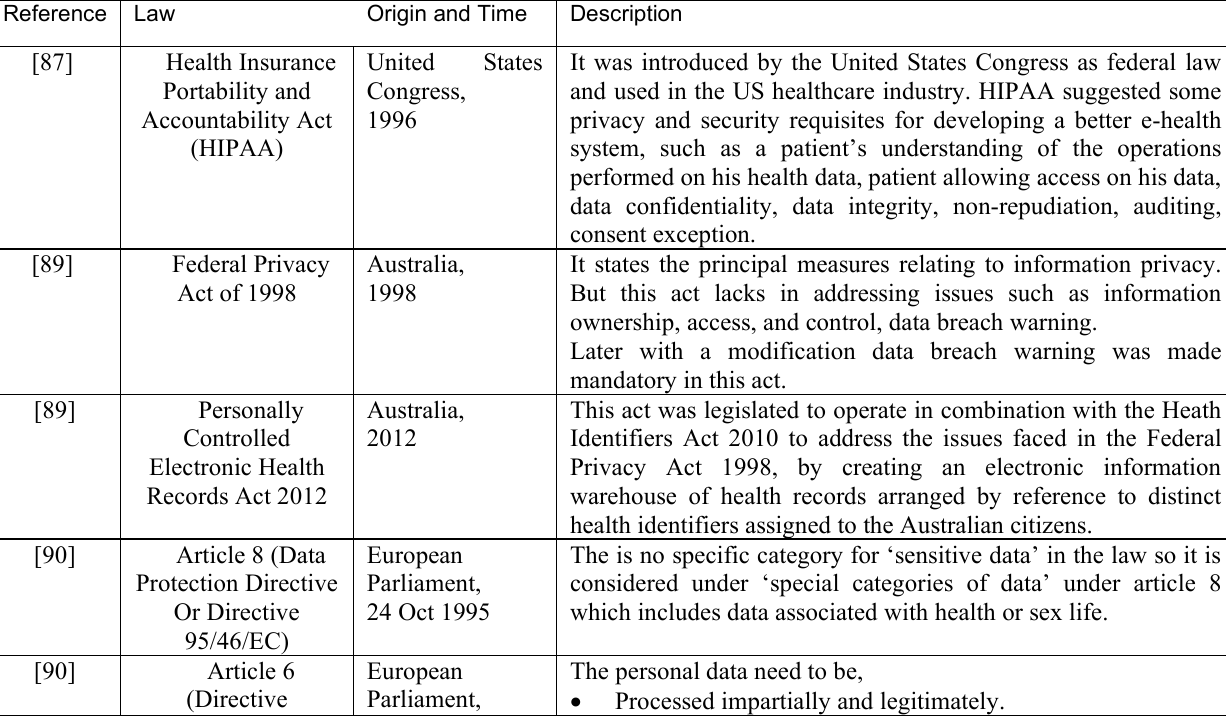
Table (3). Security